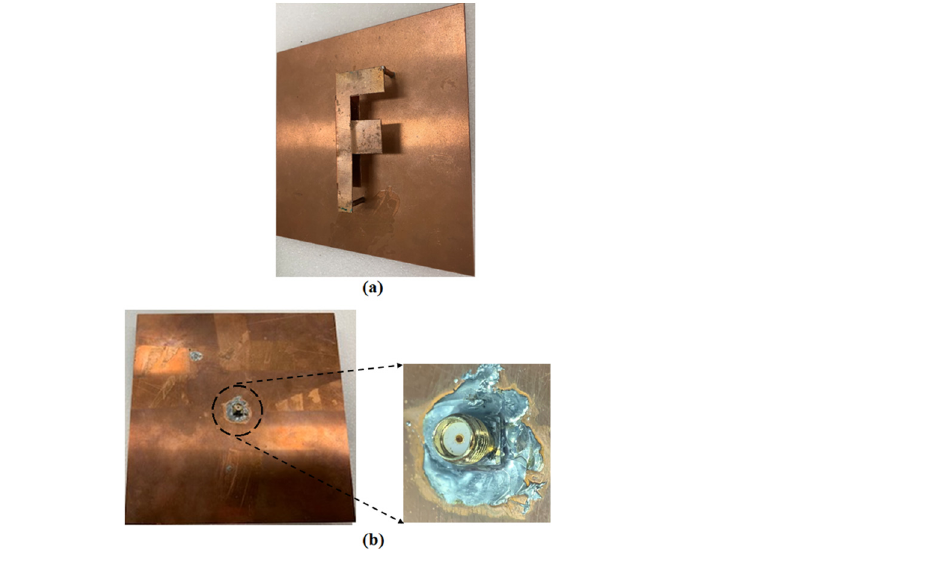
Figure 12. Fabricated prototype of the proposed patch antenna. ( a ) Top view and ( b ) bottom view.